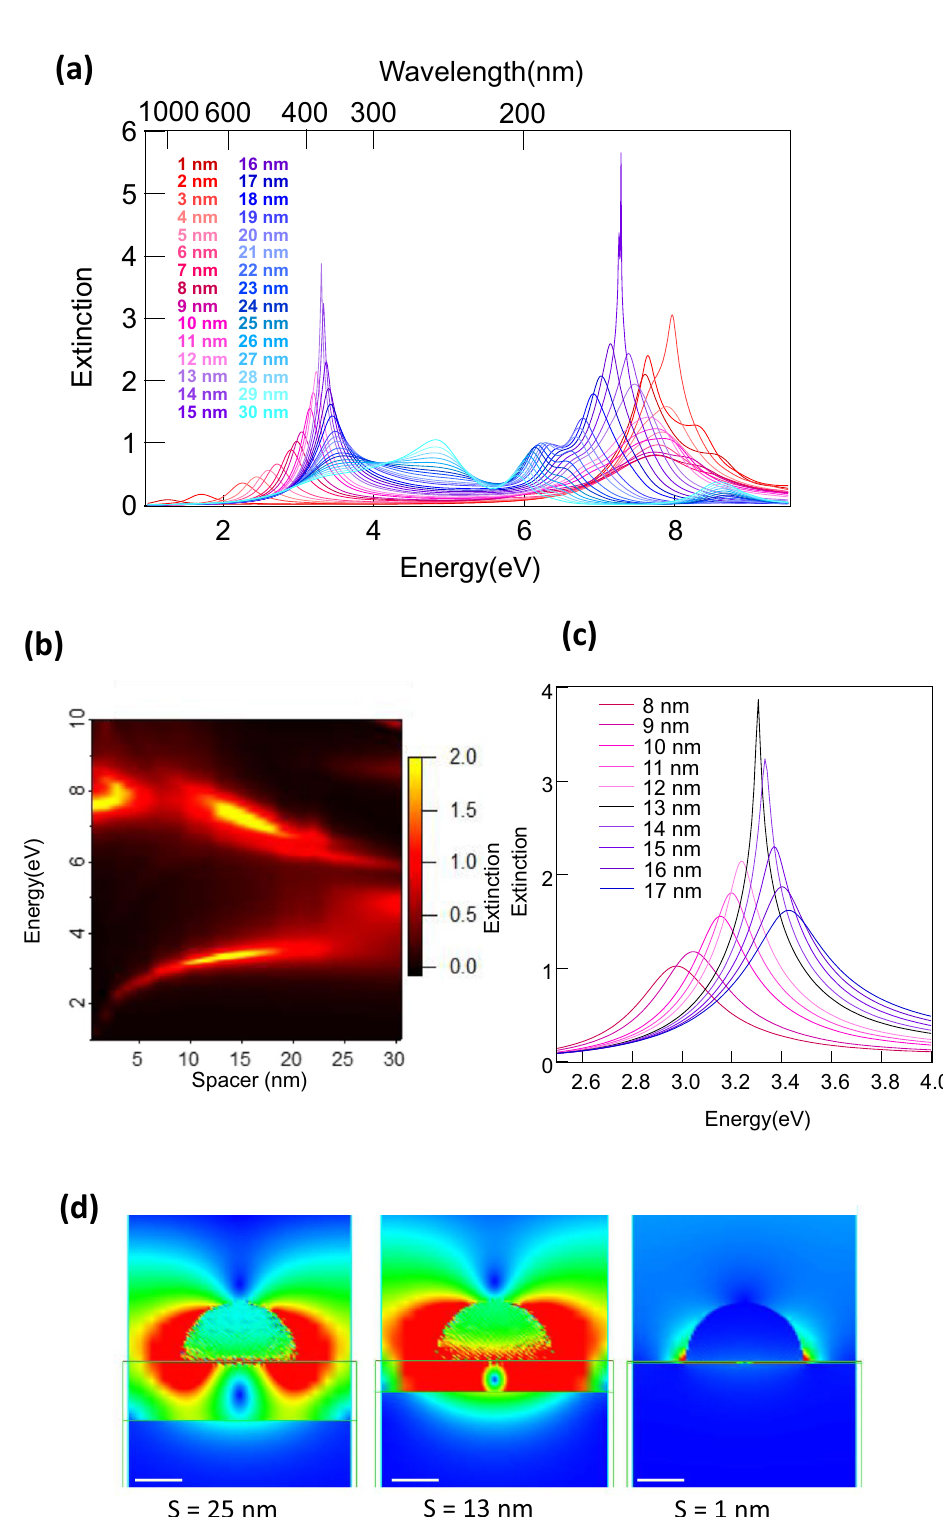
Figure 4. Spacer layer thickness dependence of the extinction spectra of NHoM structure. ( a ) Calculated extinction spectra of Al NHoM structure using Al nanohemisphere with diameter of 50 nm. The Al 2 O 3 spacer layer thickness ranged from 1 to 30 nm. ( b ) Relationship between peak wavelength of short and long branches and Al 2 O 3 spacer layer thickness from 1 to 30 nm. ( c ) Long branch of Al 2 O 3 spacer layer with thickness from 8 to 17 nm. ( d ) Spatial distribution of electric field around NHoM. The spacer layers were 1, 13, and 25